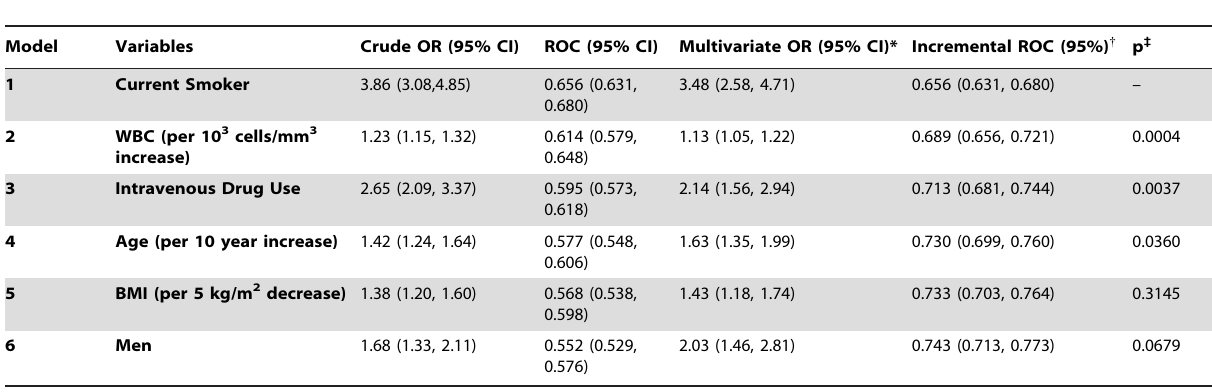
Table 5. Risk Predictors for Bronchiolitis or Emphysema Detected on CT Scans.